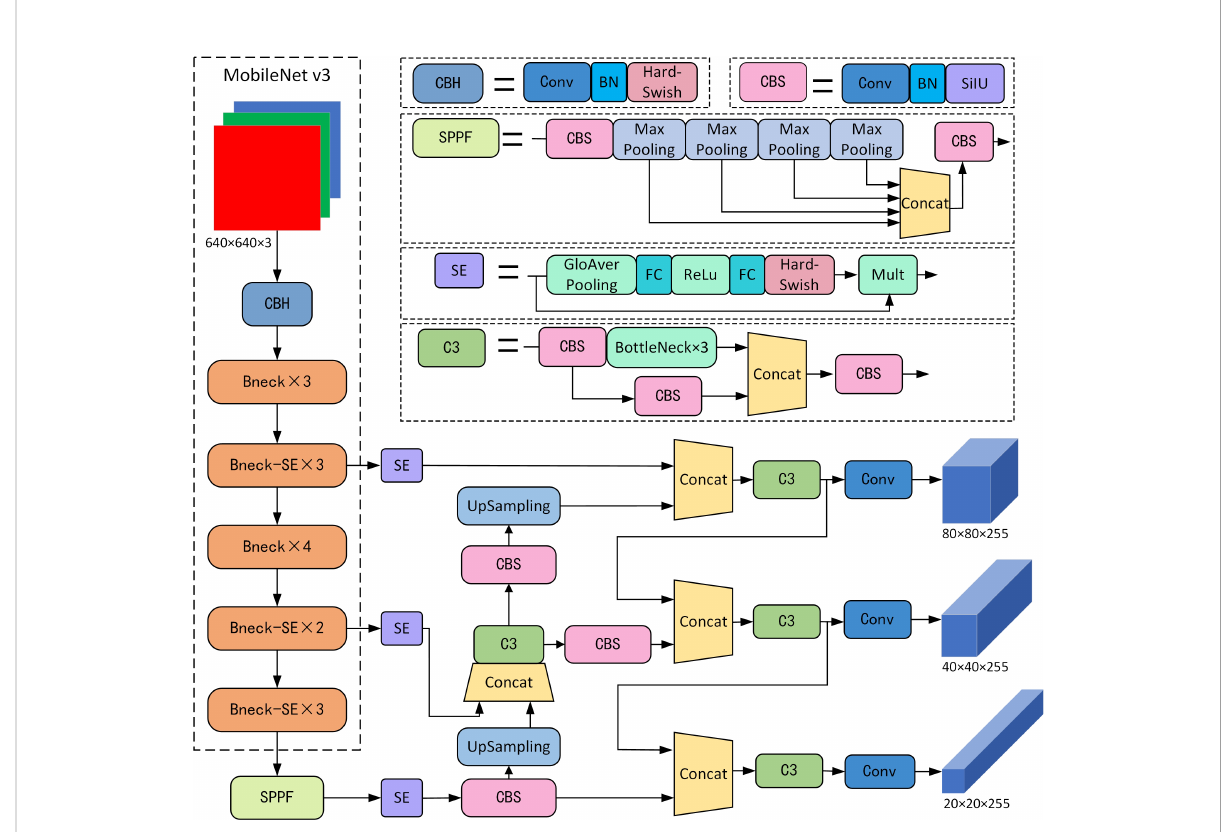
FIGURE 7 YOLOv5-MobileNetv3-SE model network